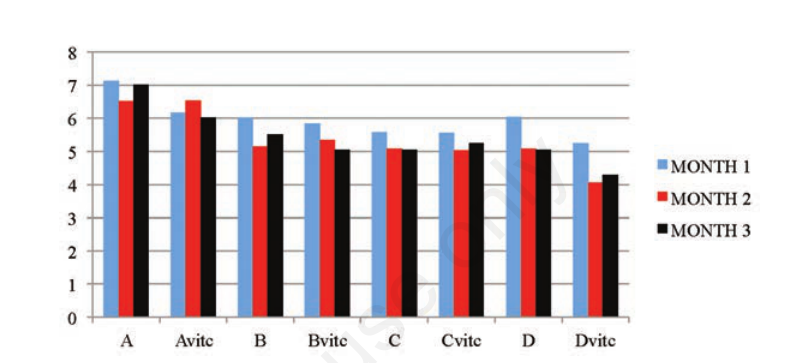
Figure 2. The mean urine pH values of the different subgroups during the three months study period.